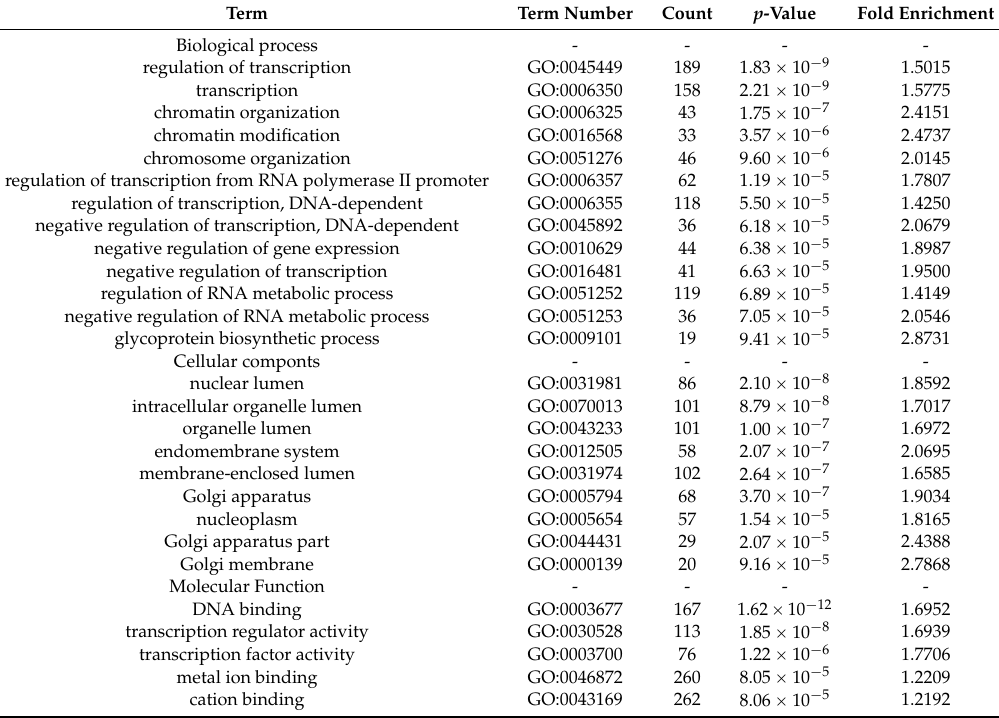
Table 4. Annotation of LC group hypomethylated promoter genes ( p value < 0.00001).